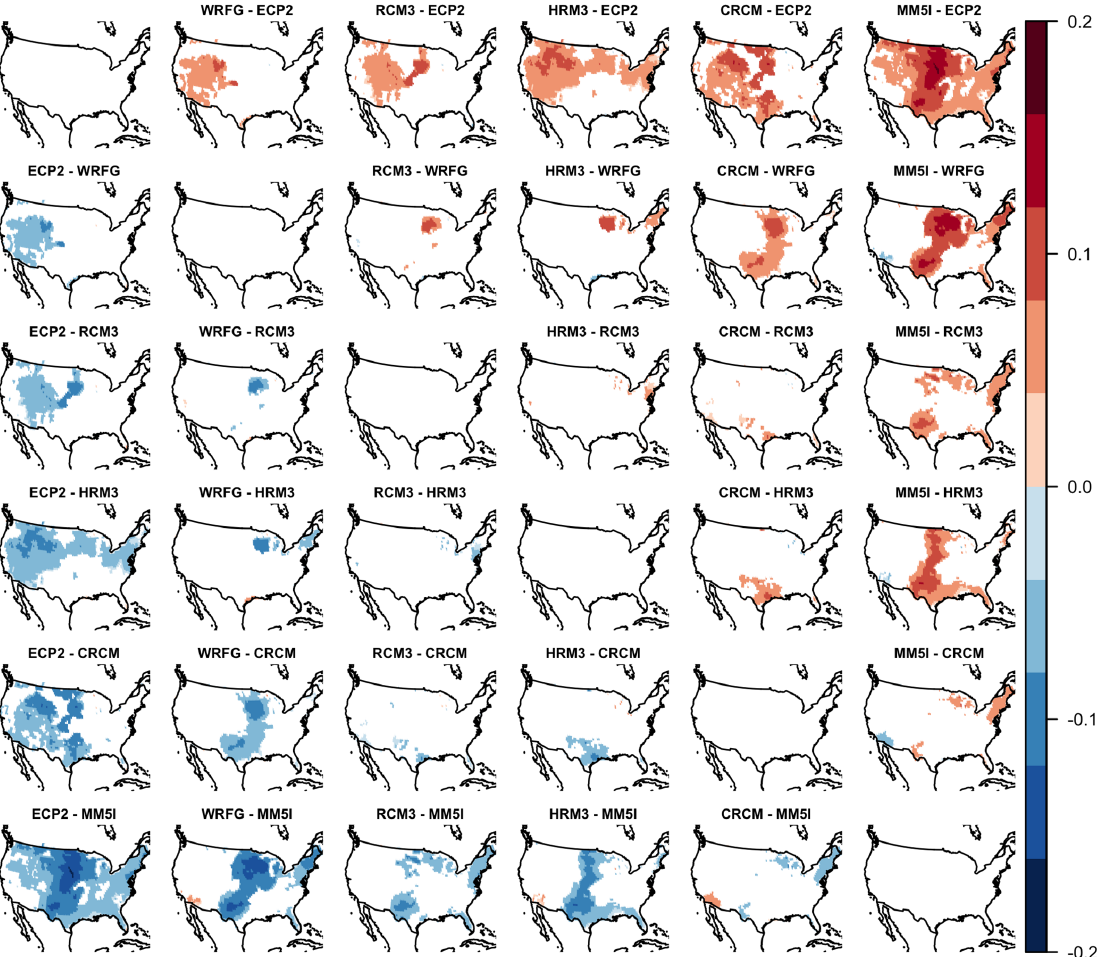
Figure 12. A heat map of the estimated average pairwise difference in rate of temperature change for RCM effects for the ASL model. Only significant locations at the 0.10 level using pointwise inference are